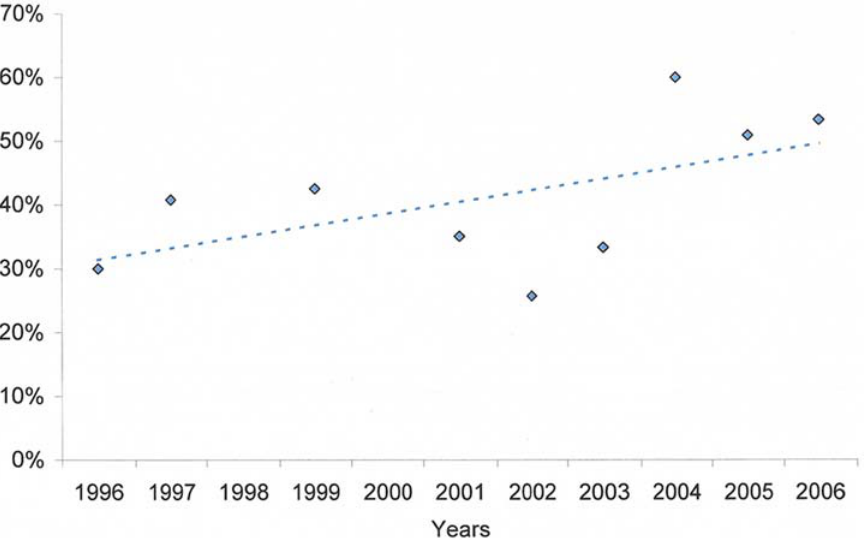
Figure 5. Proportion of primary infections with increased Pfmdr1 ( $ 2) copy number. Isolates from primary infections were used for genetic analysis between 1996 and 2006. Increase in isolates with 2 or more copy number is given in percentage of the total.